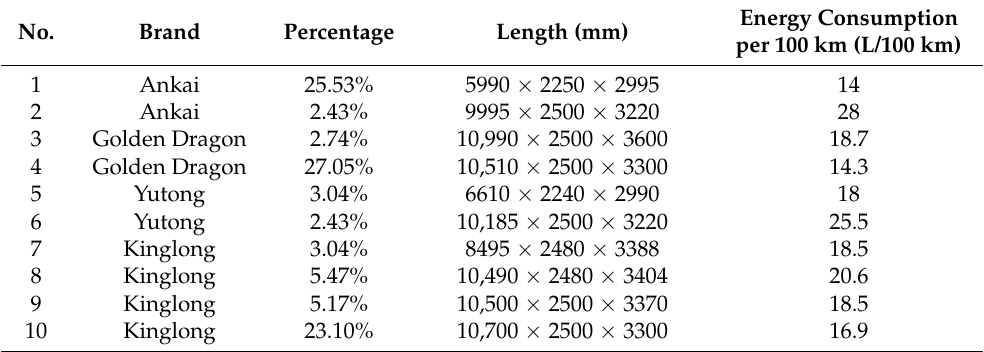
Table 6. Relevant parameters of diesel bus brands.